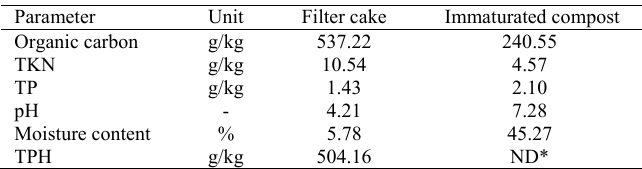
Table 1: Physicochemical properties of the filter cake and compost Parameter Unit